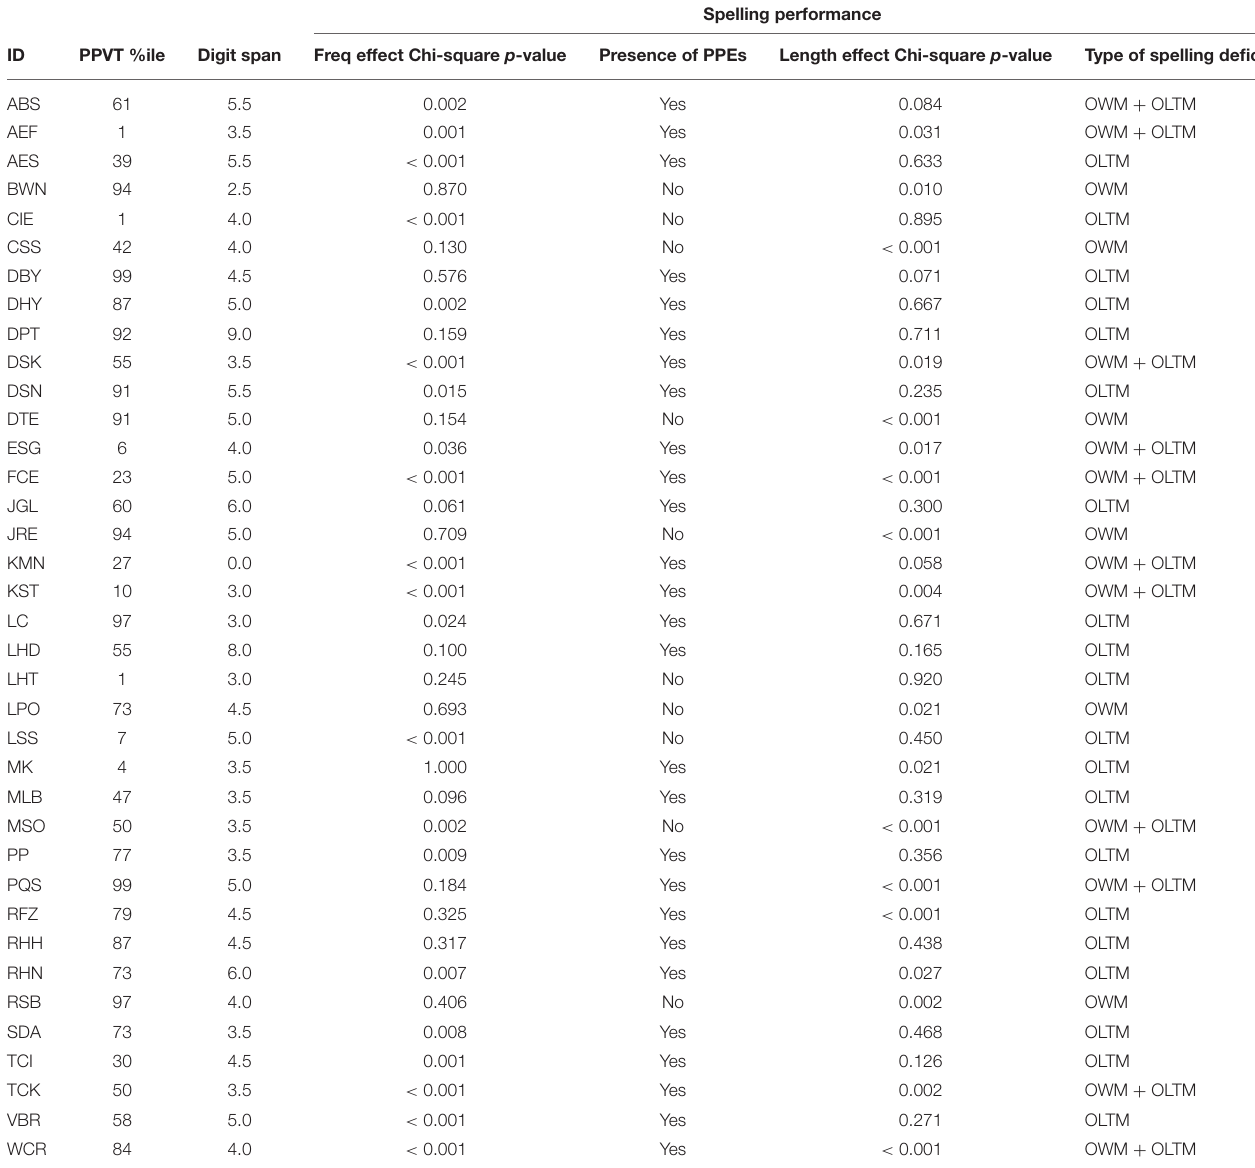
TABLE 3 | Behavioral profiles and indices of PWM, OWM, PLTM and OLTM used in the analyses.